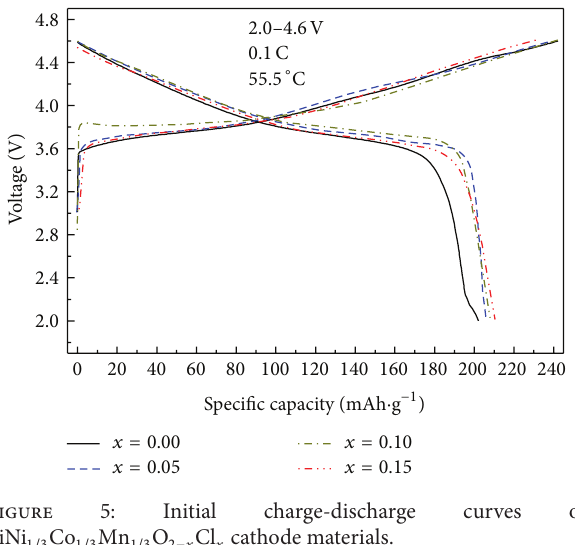
5: Initial charge-discharge curves of LiNi 1/3 Co 1/3 Mn 1/3 O 2−𝑥 Cl 𝑥 cathode materials.